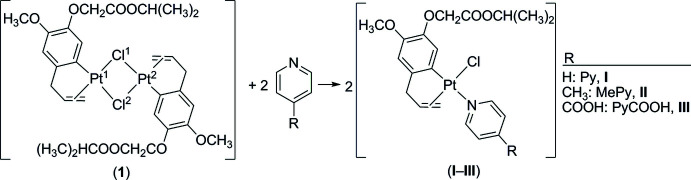
Reaction scheme for the synthesis of mixed iPrEug-pyridine derivative platinum(II) complexes (I), (II) and (III).